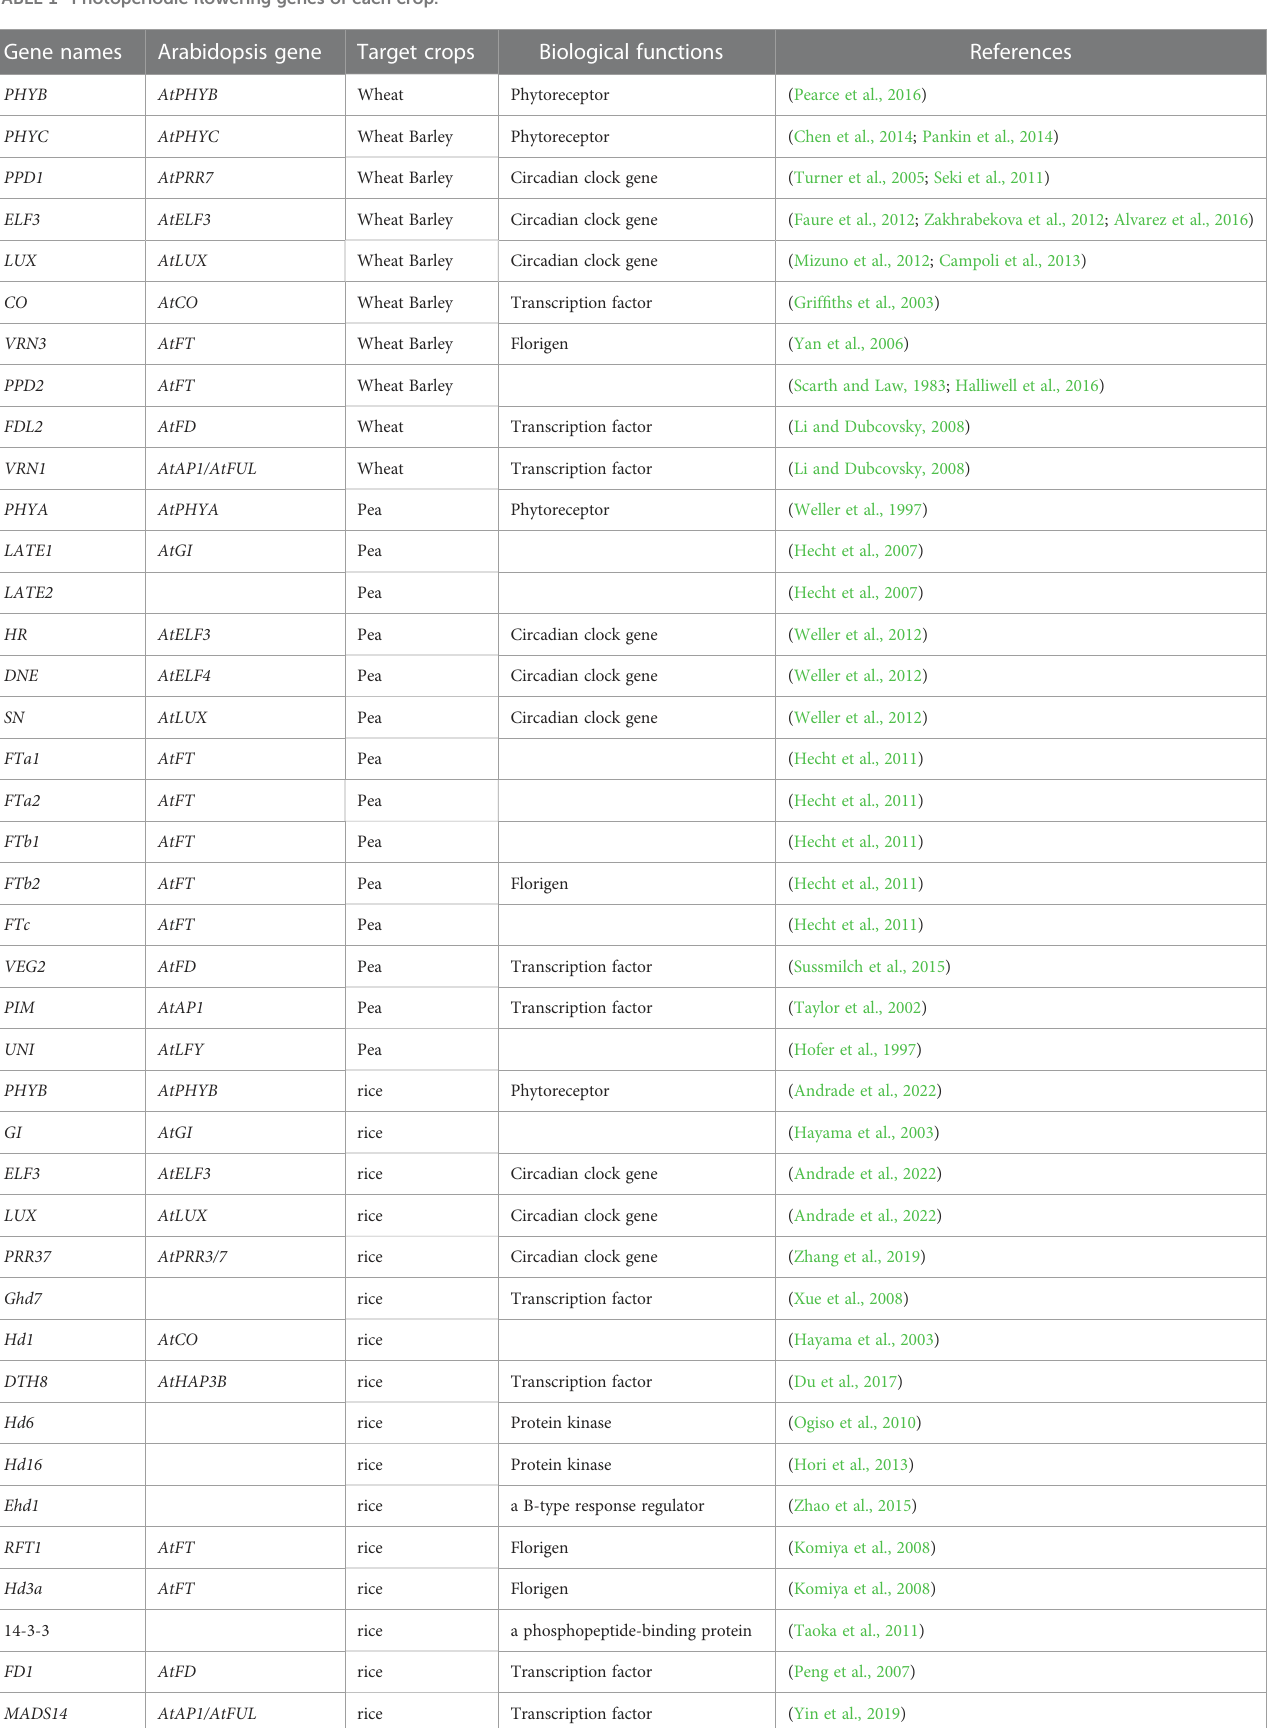
TABLE 1 Photoperiodic fl owering genes of each